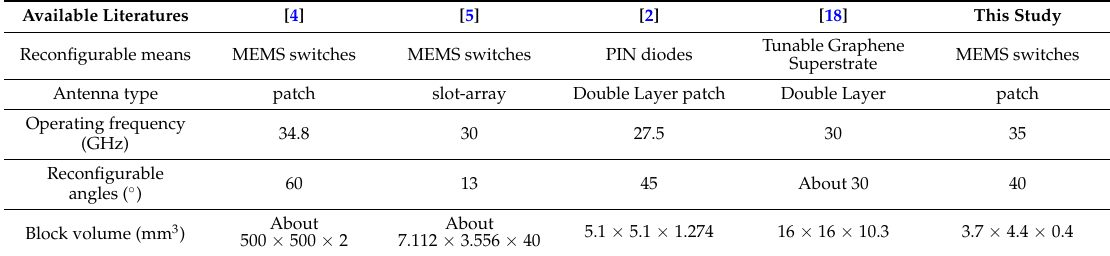
Table 5. Performance comparison of the proposed pattern reconfigurable antenna with the literature.